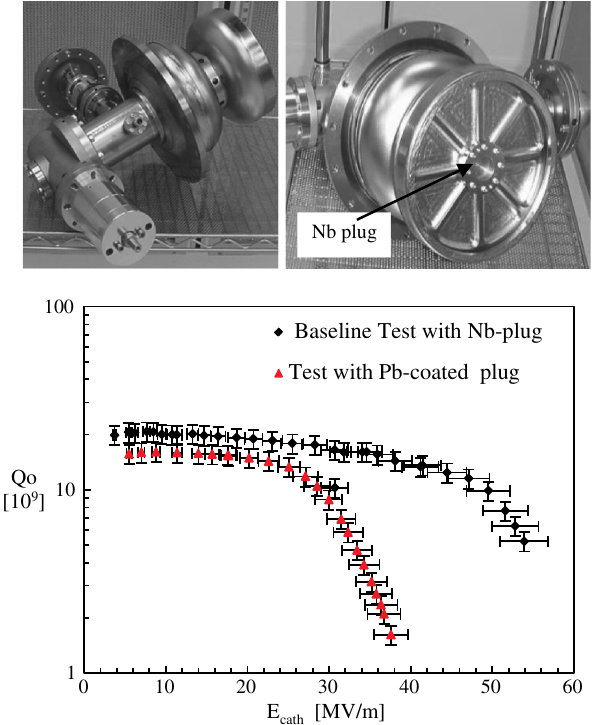
FIG. 14. Pictures and test result of the SRF gun 1.6-cell cavity; uncoated Nb plug (black), Pb coated plug